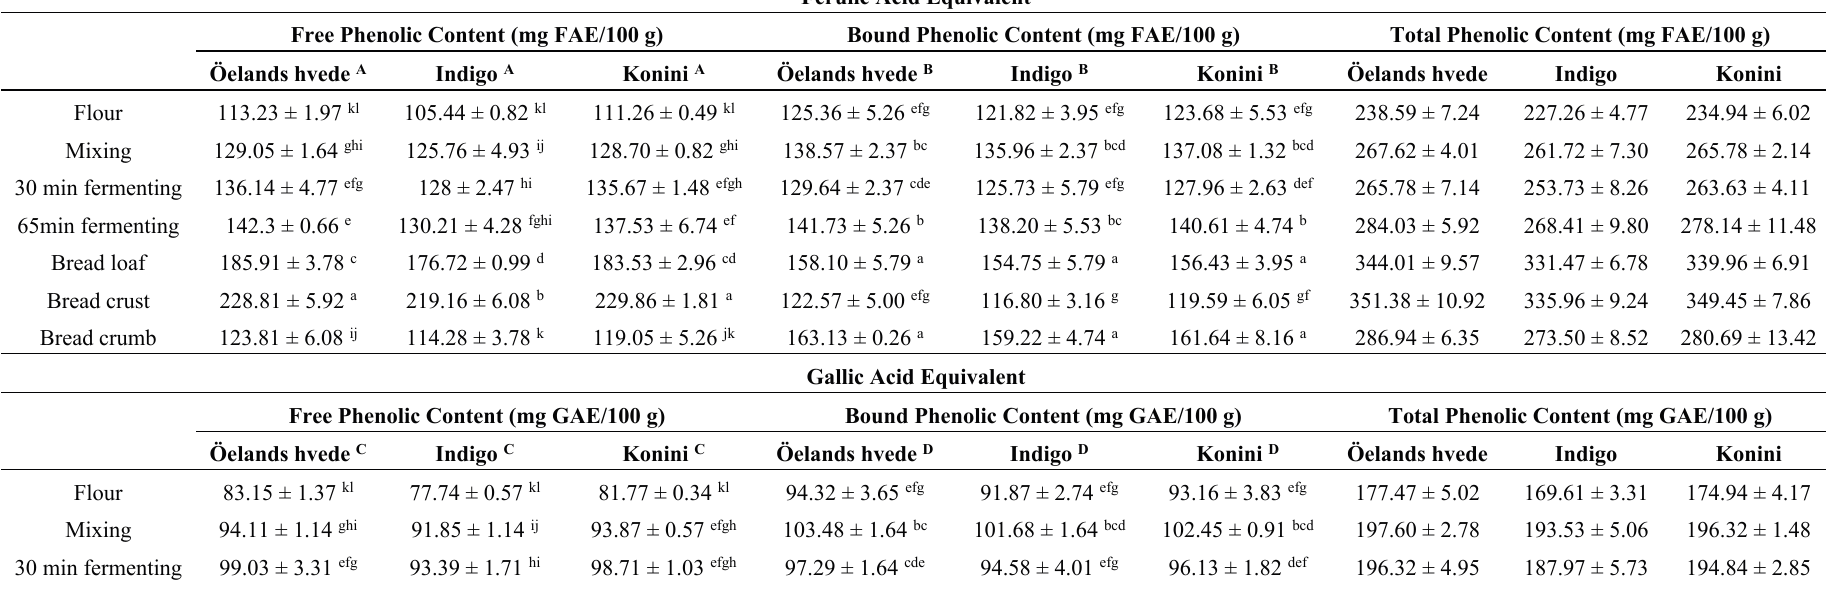
Table 1. Free, bound, and total phenolic content of common and purple wheat grains at different stages of the bread-making